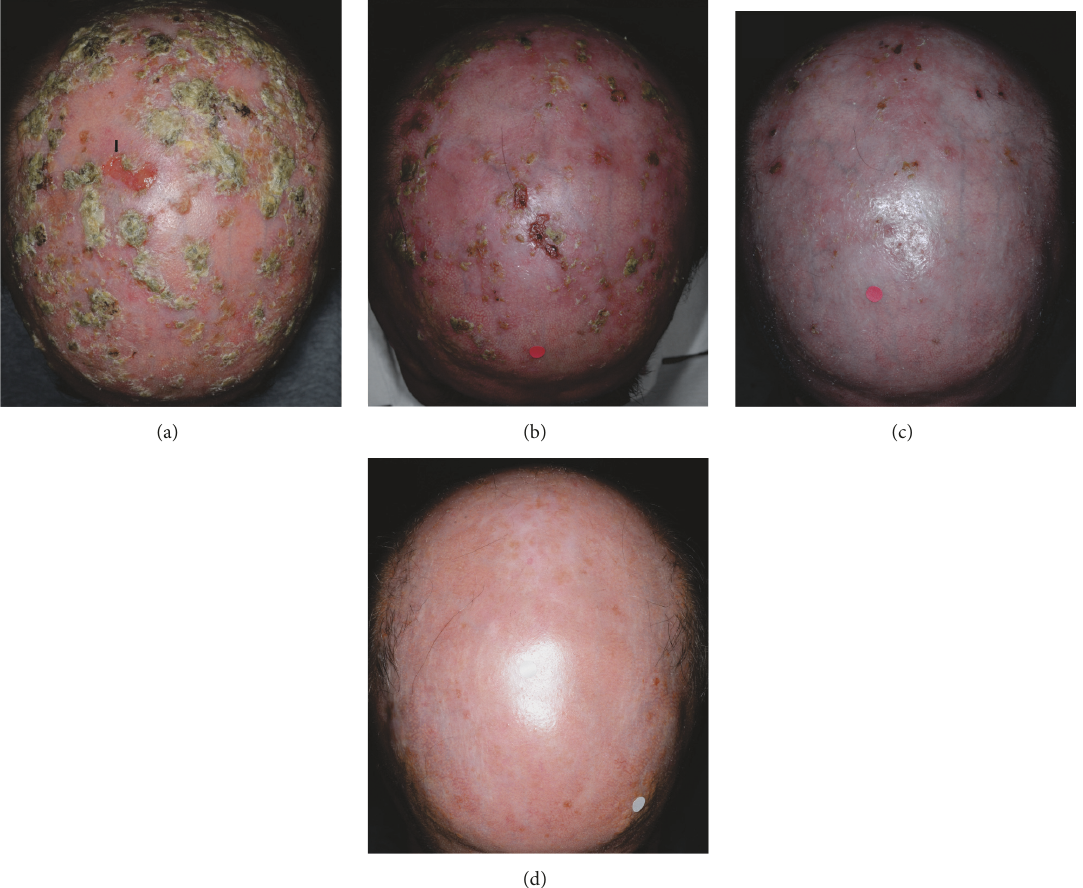
Figure 1: Complete and sustained remission of extensive hydroxycarbamide-associated skin carcinogenesis fields after switching to anagrelide: exemplary presentation of the alterations on the balding scalp skin. (a) At presentation numerous, confluent, hypertrophic actinic keratoses cover almost the entire scalp. Removal of the hyperkeratosis revealed an oozing erosion (arrow). (b) A significant load of actinic keratoses persists 3 months after onset of treatment with cryosurgery plus ingenol mebutate (7 treatment cycles) and daily 0.32 mg/kg b.w. acitretin. At that point acitretin dose was doubled (0.64mg/kg b.w./d) and the patient was switched from hydroxycarbamide to anagrelide. (c) Impressive improvement after one month in the last treatment scheme (anagrelide and acitretin, no topical treatments). (d) Sustainable “clearance” of the field 20 months after discontinuation of acitretin and still on anagrelide: complete regression of existing and no development of new actinic